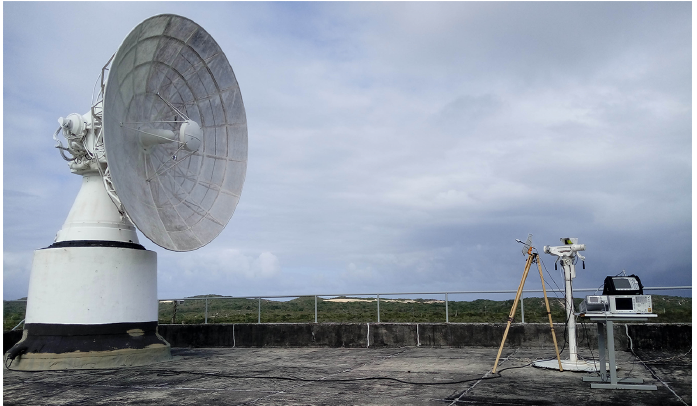
Figure 3. P01 measurement point: Béarn’s antenna on the ( left ) and its optic designation instrument on the ( right